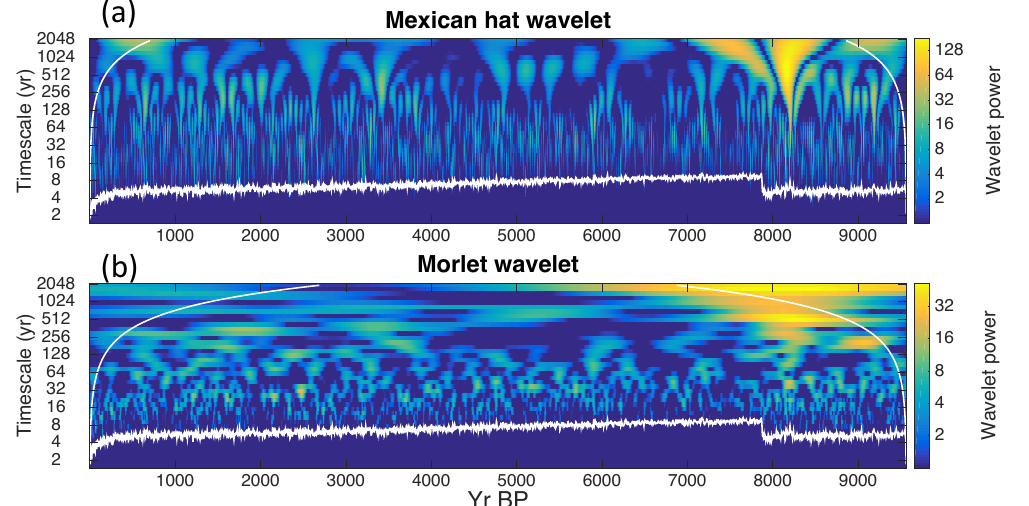
Figure 11. Top panel: the Mexican hat wavelet scalogram for the Holocene part of the GRIP ice core. Bottom panel: the Morlet wavelet scalogram for the same time series. The lower white curve in each plot denotes the varying Nyquist frequency, and the upper white curve the area affected by edge effects. Studies are restricted to the area between the two curves. The colour bar to the right of the figure is used to indicate the magnitude of the wavelet